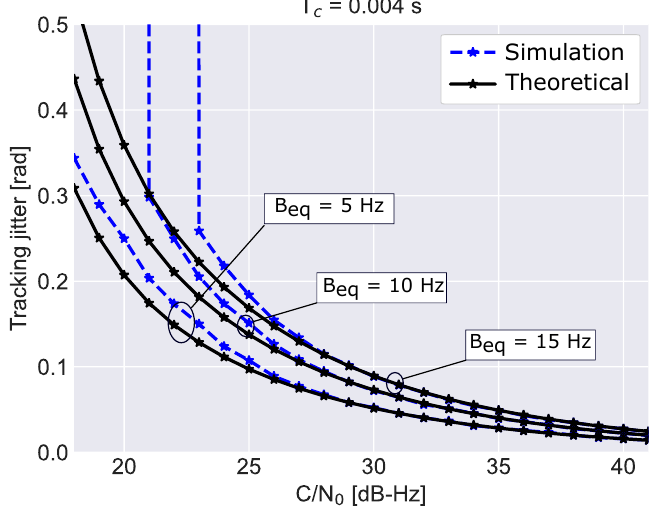
Figure 2. Comparison between the theoretical tracking jitter and simulation results. Different loop equivalent bandwidths are considered for a single non-coherent integration, K = 1.